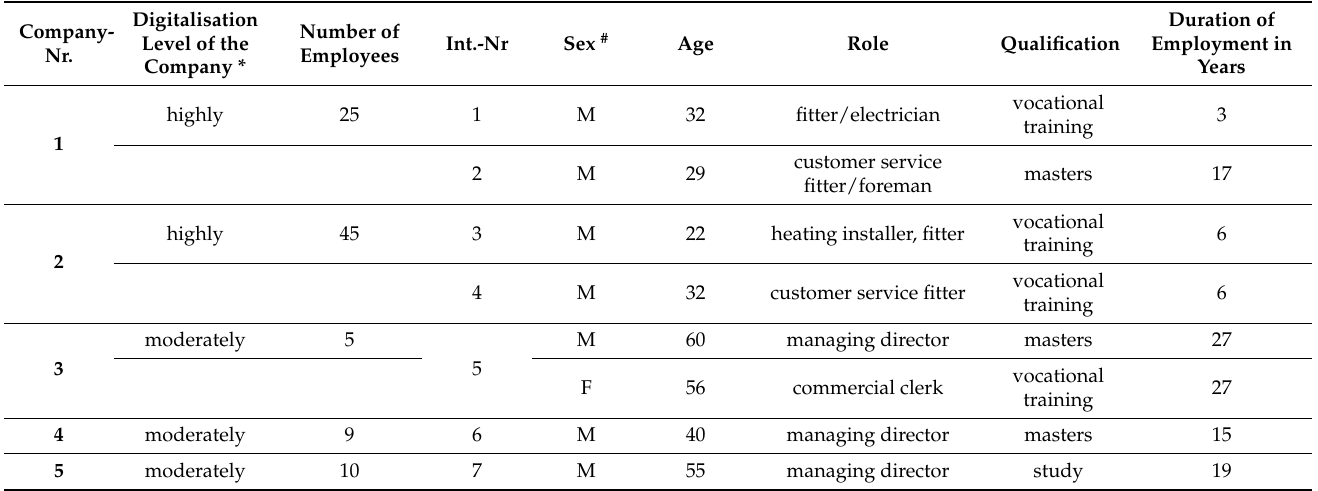
Table 1. Overview of participants and craft